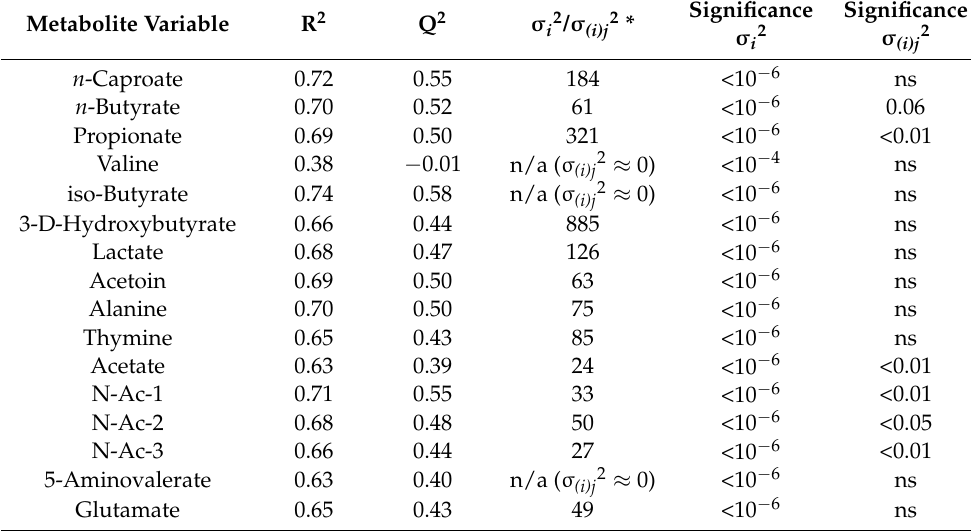
Table 4. Statistical significance of the ‘between-participants’ and ‘between-sampling days-within- participants’ ( σ i 2 and σ (i)j 2 , respectively) components of variance in a random effects ANOVA model to determine their contributions towards the WMS supernatant concentrations of a total of 31 1 H NMR-assigned metabolite variables. All TSP-normalized datasets were glog-transformed and Pareto-scaled prior to analysis. Also shown are the R 2 and Q 2 values for each of these UV models, along with their σ i 2 / σ (i)j 2 ratios. * Indicates that values were rounded to the nearest